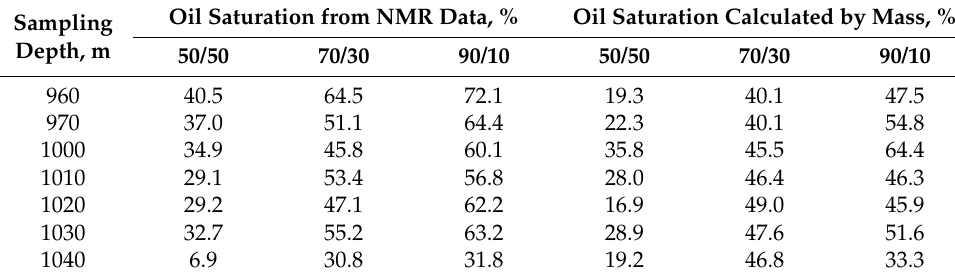
Table 5. Oil saturation of the drill cuttings (oil C), calculated by mass and NMR data. Oil Saturation from NMR Data, % Oil Saturation Calculated by Mass, % Sampling Depth, m